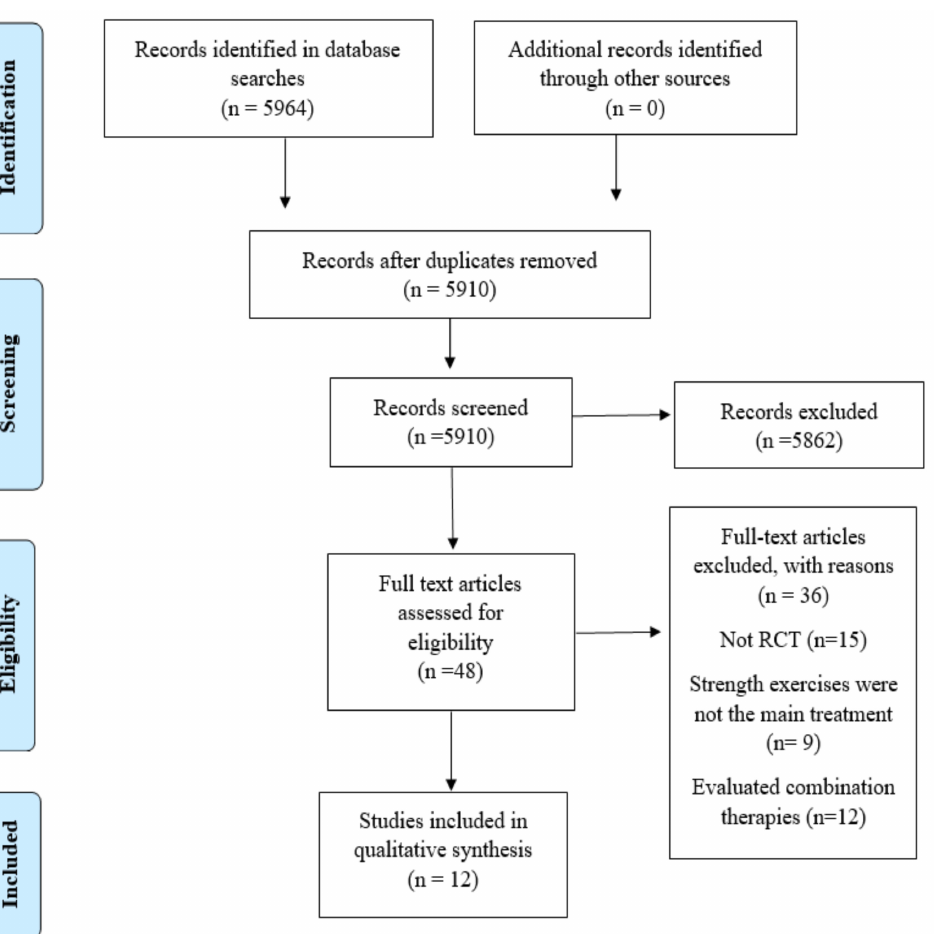
Figure 1. Eligibility and data synthesis: PRISMA flow